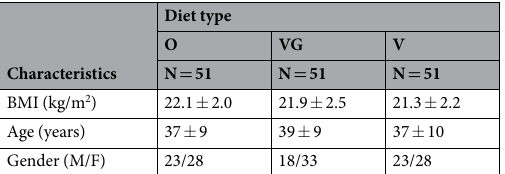
Table 1. Characteristics of the participants for each of the three diet groups. Values are mean ± standard deviation of fifty-one independent measurements. N, total number; M, male; F, female.